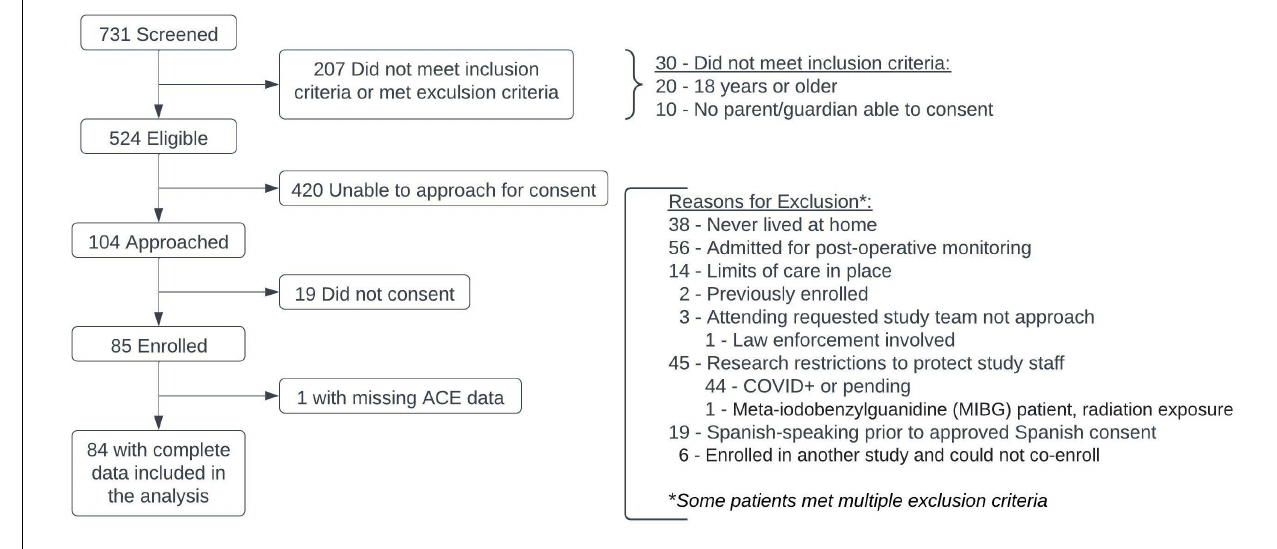
FIGURE 1 | CONSORT diagram of PICU